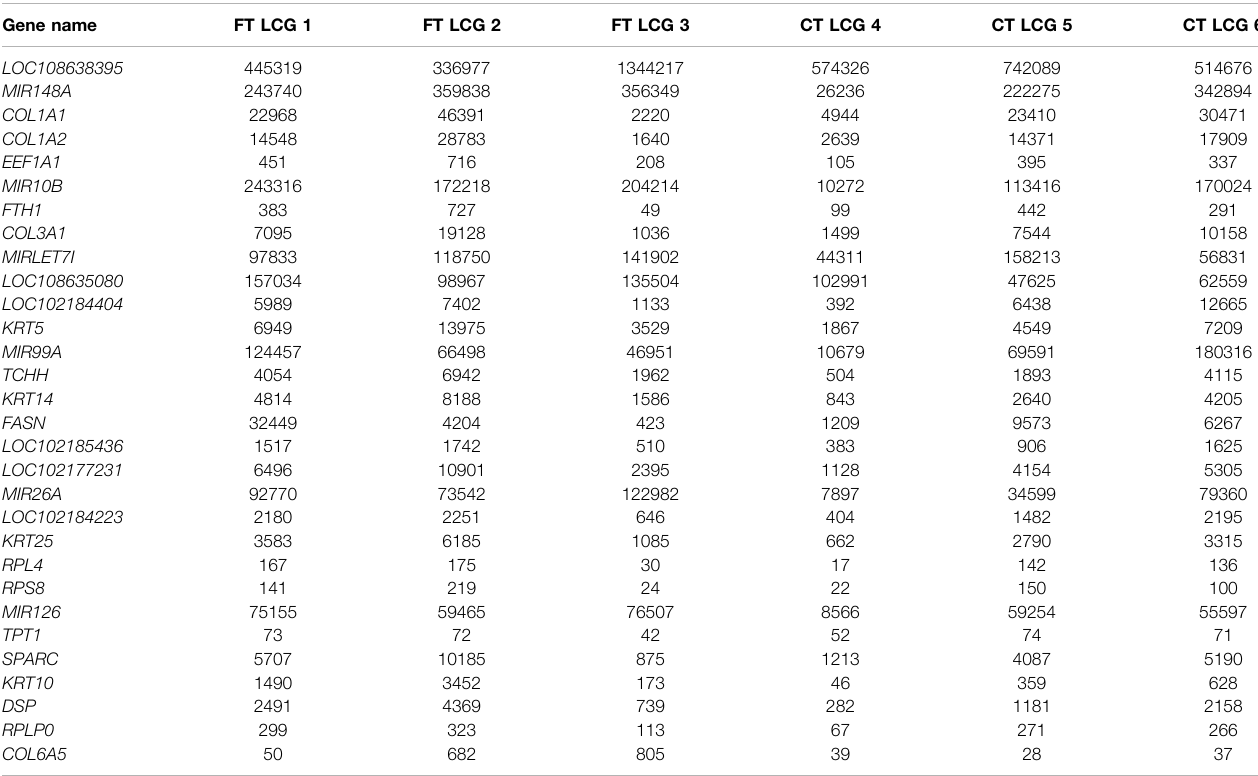
TABLE 2 | Quantitative analysis table of the fi rst 30 gene expression levels of each